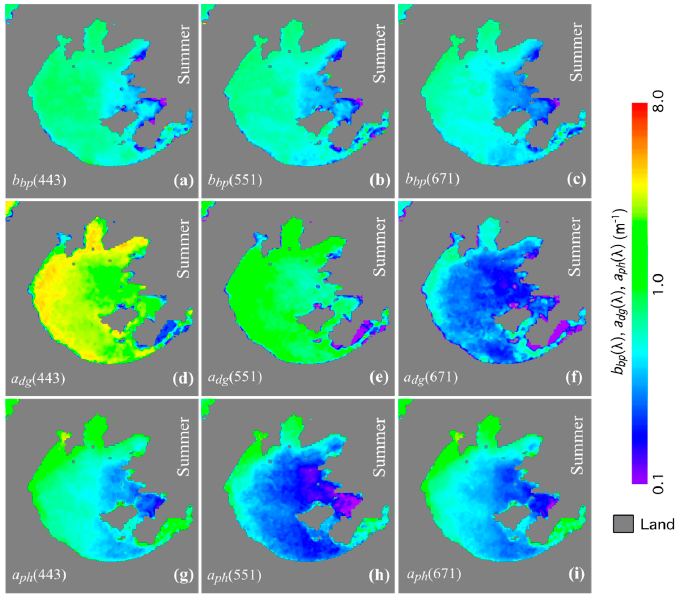
Figure 7. VIIRS-derived IOP in Lake Taihu during the summer season between 2012 and 2018 for ( a – c ) b bp ( λ ), ( d – f ) a dg ( λ ), and ( g – i ) a ph ( λ ) at the VIIRS bands of 443 nm (left column), 551 nm (middle column), and 671 nm (right